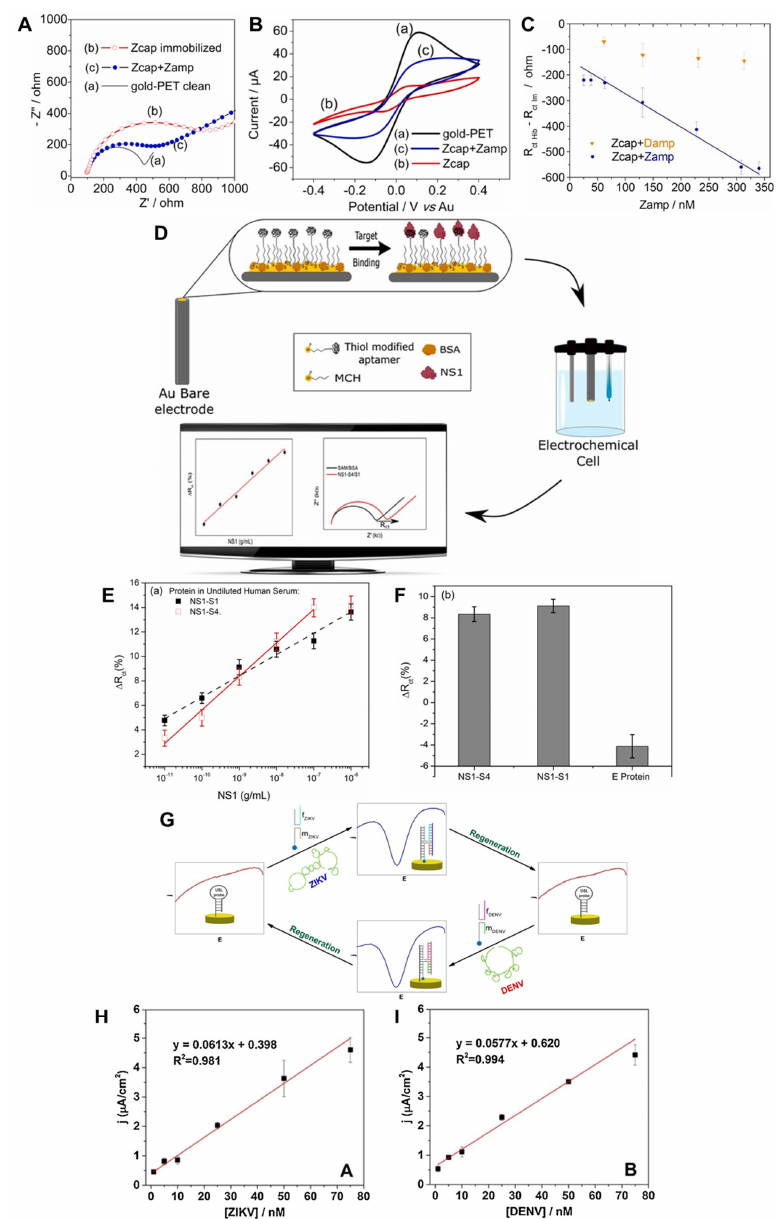
Figure 3. DNA − technology − based ZIKV and DENV detection method using electrochemical